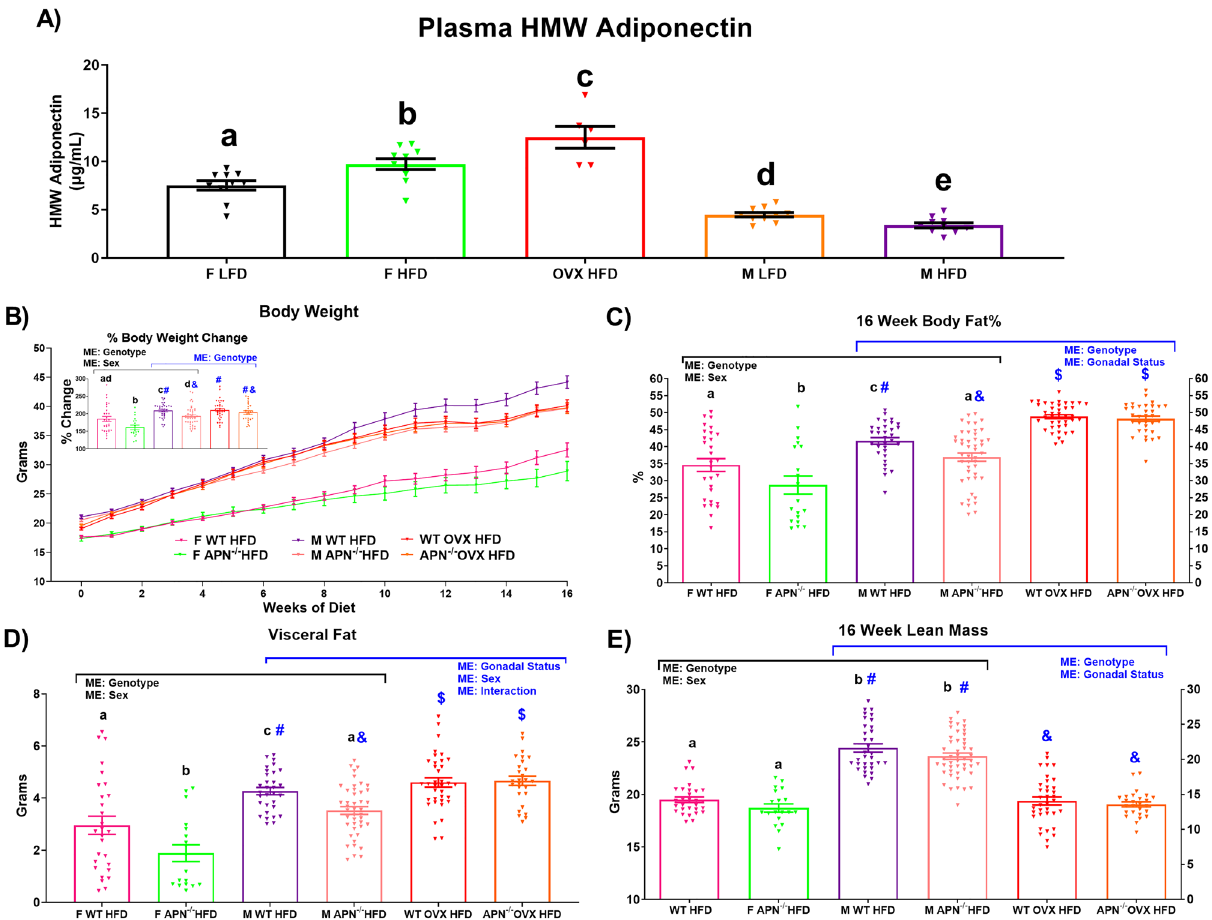
Figure 4. Estrogen deficiency increases high-molecular-weight (HMW) adiponectin (APN), and APN deletion mitigates HFD-induced body fat accrual in gonadally intact males and females but not in ovariectomized females. After 16 weeks of LFD or HFD, ( A ) plasma was assessed for HMW APN in WT mice (n = 6–10). A subsequent 16-week HFD experiment was performed utilizing male and female (both intact and OVX) APN deficient mice (M and F APN −/− ) and wildtype (WT) littermate controls (n = 19–46). The data is presented as follows, ( B ) body weight over the course of the study as well as % body weight change from baseline, ( C ) body fat %, ( D ) visceral fat accumulation, and ( E ) lean mass. Bar graphs not sharing a common letter or symbol are significantly different from one another (P < 0.05). ME = Main